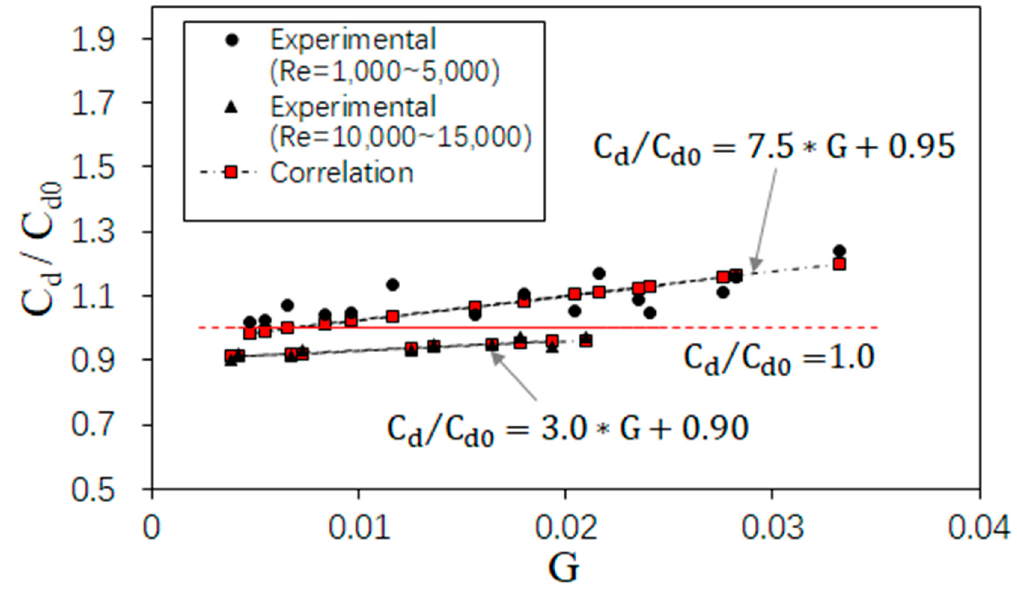
Figure 23. Discharge coefficient ratio as dependent upon G for Re j = 1000, 2500, 5000, 10,000, and 15,000, including comparison with correlation data.